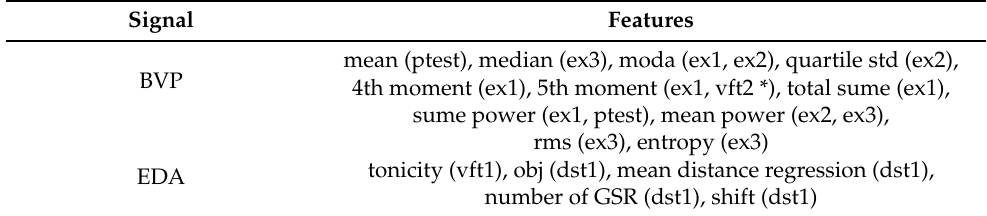
Table 5. Features selected using the JMI method.